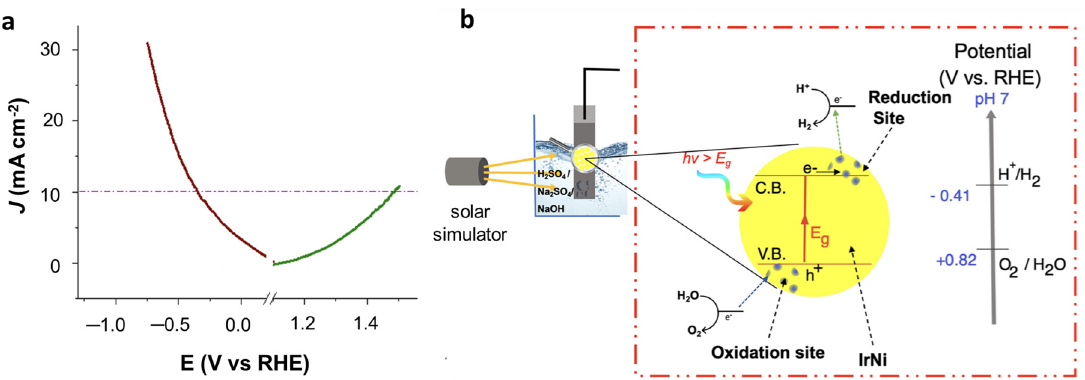
Figure 8. ( a ) Overall water splitting performance of 4Ir1Ni@AC catalyst in 0.1 M NaOH electrolyte in a two-electrode setup under illumination of 1 sunlight. ( b ) Schematic diagram of the photoelec- trochemical process occurring on IrNi particle irradiated with light.